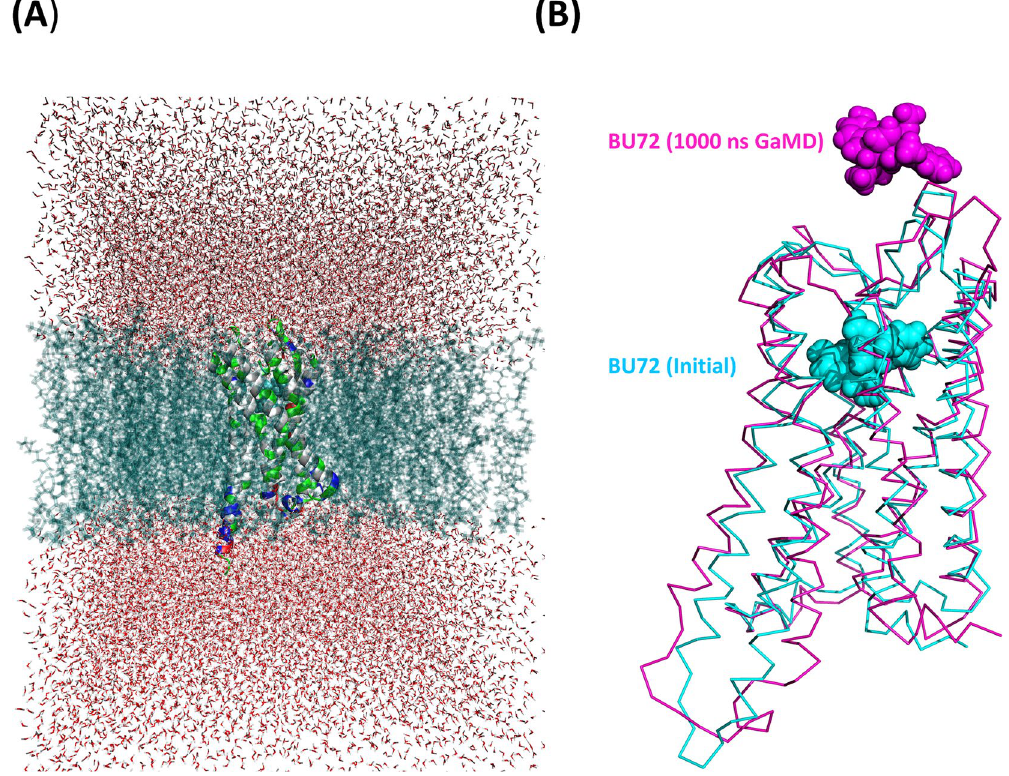
Figure 5. ( A ) Initial structure of an active MOR with BU72. ( B ) Snapshots of an active MOR with BU72 (cyan: initial structure; magenta: structure derived after 1000-ns